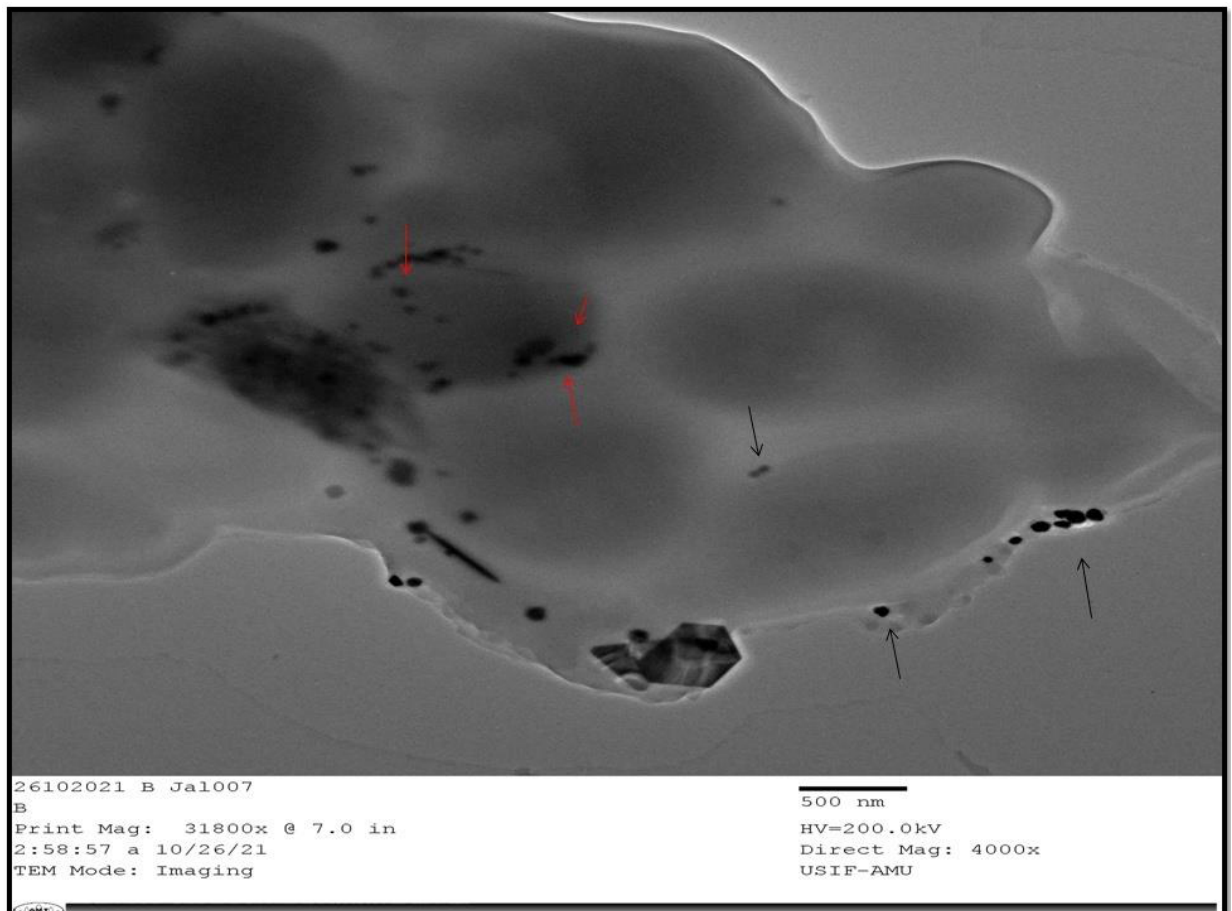
Figure 7. TEM image of C. albicans treated with CS-AgNPs at 500 µg/mL. Black arrows indicate CS- AgNPs at the surface, whereas red arrows indicate the internalization of CS-AgNPs.